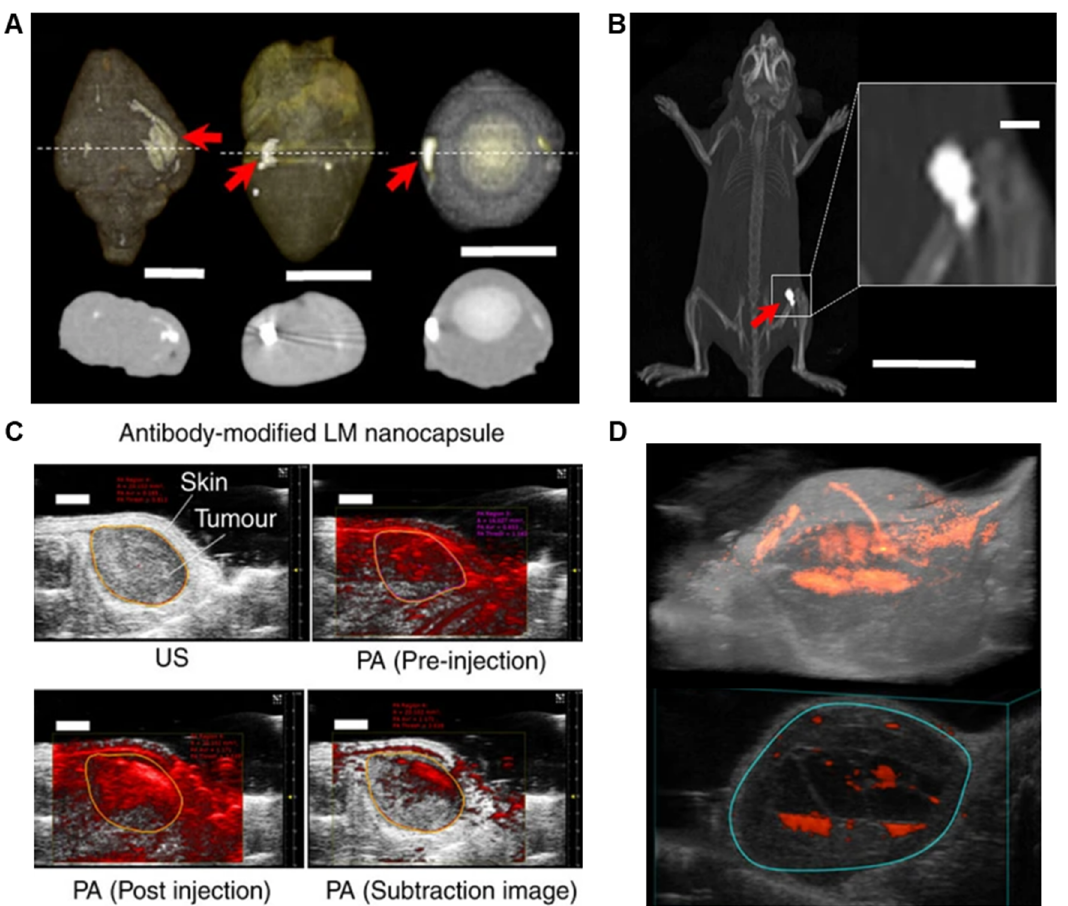
Figure 7. ( A ) X-ray images of cross-sectional views of rabbit heart, brain, and eyeball, respectively. The laser-irradiated sites are indicated by red arrows. Scale bar, 1 cm. ( B ) X-ray image of a living mouse with LMNPs injection. The laser-irradiated site is indicated by the red arrow. Scale bar, 3 cm (inlet: 2 mm). ( C ) LMNPs (100 µ g / mL) were injected into the tumor site of living mice. Ultrasound (US) (grey) and PA (red) images were taken through the tumor by 750 nm laser excitation. The orange circle shows the part to be analyzed. Scale bars are 2 mm. ( D ) 3D imaging of the tumor site. The blue circle shows the tumor region. Reproduced with permission from NPG [7].